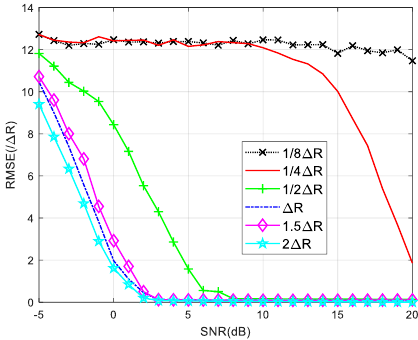
Figure 6. RMSE against input SNR with different range intervals by RELAX.